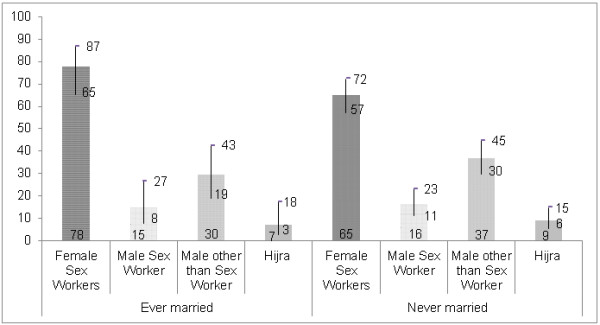
Type of high-risk sexual partner, by marital status (with 95% CI).